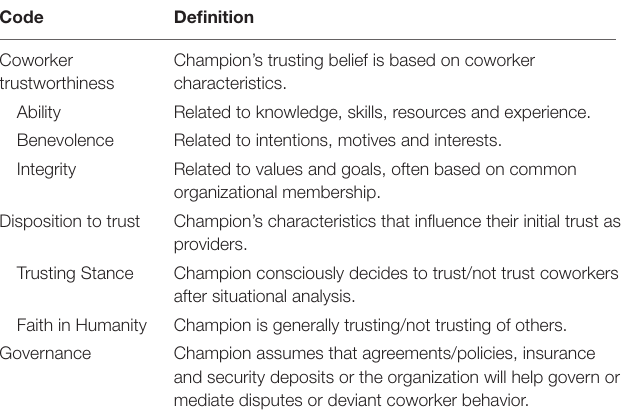
TABLE 2 | Trust codes and themes.